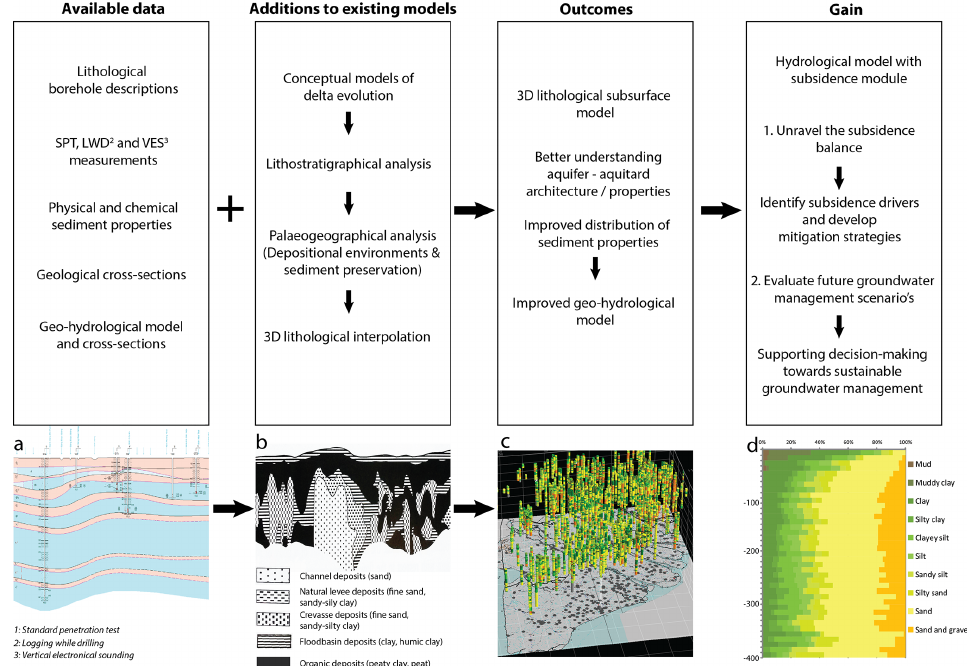
Figure 3. Workflow to develop the 3-D lithological subsurface model of the Mekong Delta, improve the geo-hydrological model and analyze the potential for subsidence driven by groundwater extraction. Steps graphically depicted below the workflow. (a) Cross-section of current geo-hydrological model. (b) Example of a cross-section including geomorphological elements as a result from lithological and palaeogeographical analyses (modified after Bierkens and Weerts, 1994). (c) 3-D view of the new available lithological borehole data in the Mekong delta up to 500m deep. (d) Depth distribution of lithological classes for the Mekong delta. Data: © Division of Water Resources Planning and Investigation of South Vietnam